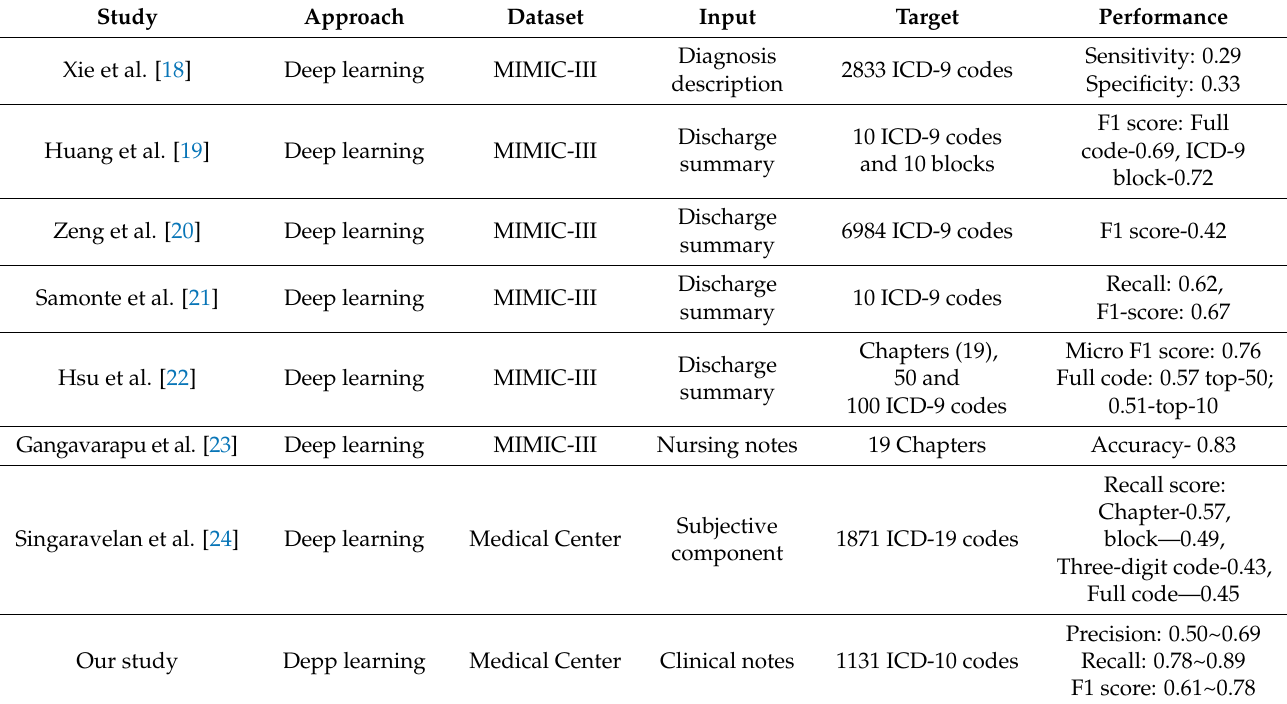
Table 3. The performance comparison between previous